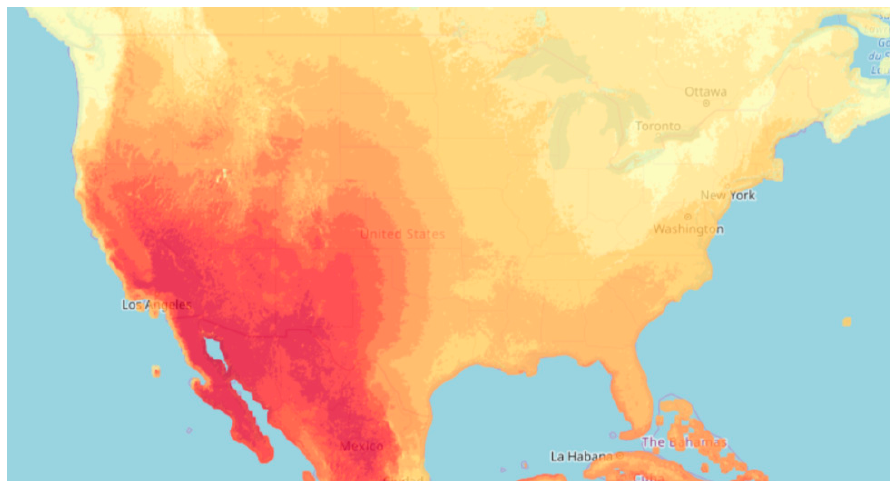
Figure 10. NSRDB data viewer. Created via the NSRDB [21].